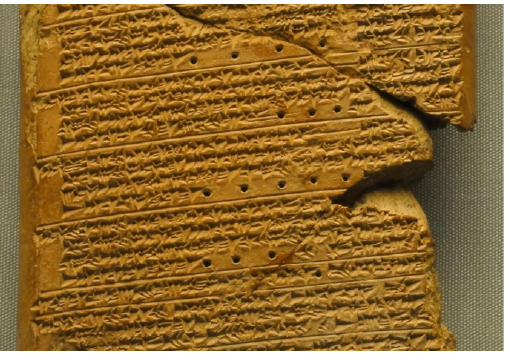
Fig. 1. Part of a clay tablet, 3 pieces, Neo-Assyrian.